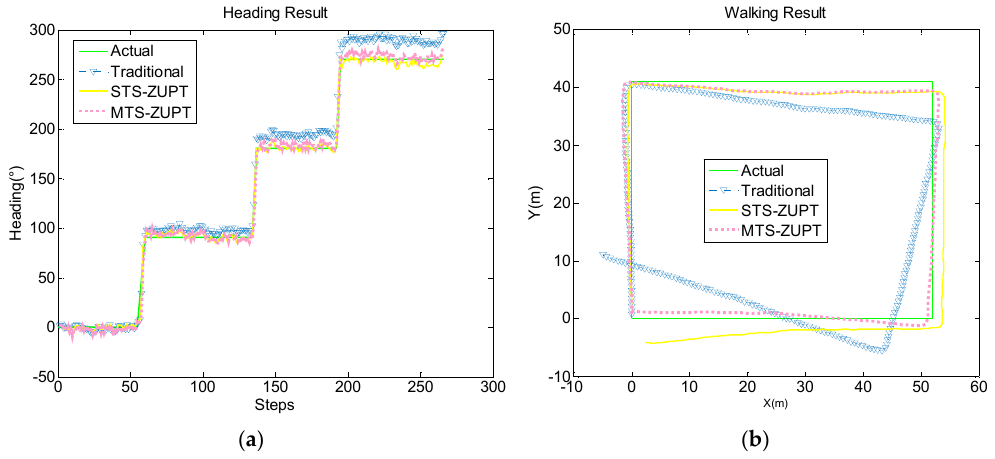
Figure 9. Rectangular Walking Result Comparison of STS-ZUPT and MTS-ZUPT. ( a ) Heading result; ( b ) Route result.